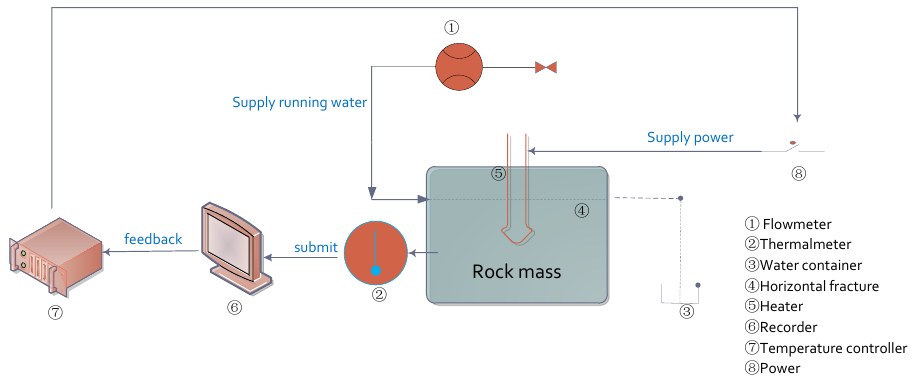
Figure 1. Flowchart of the experiment system.